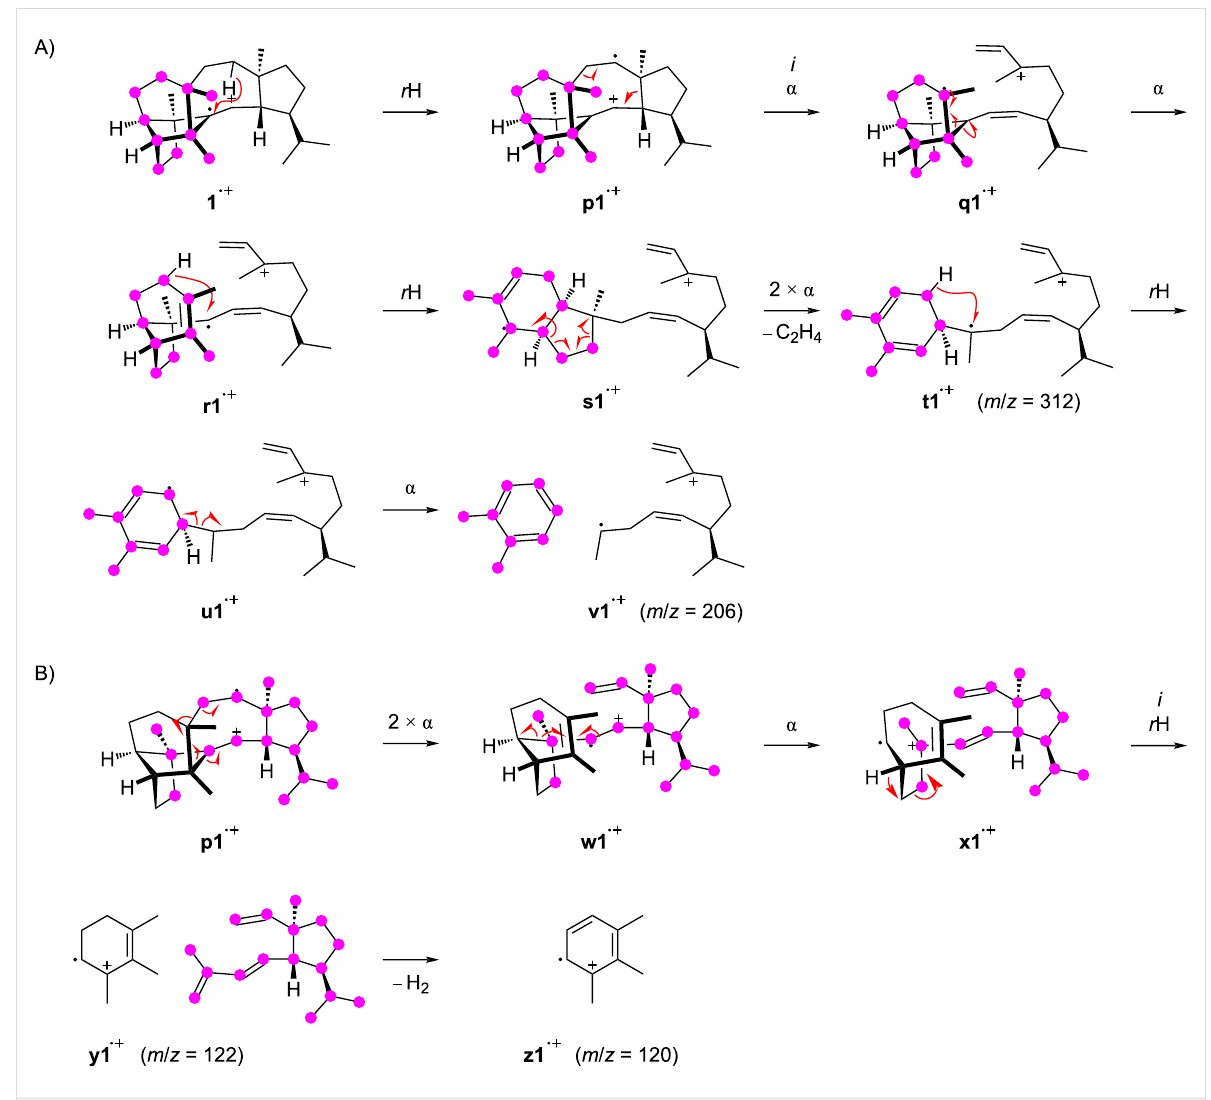
Scheme 2: The EIMS fragmentation mechanisms for 1 explaining the formation of fragment ions at m / z = 206 and 120. Lost carbons are marked by purple